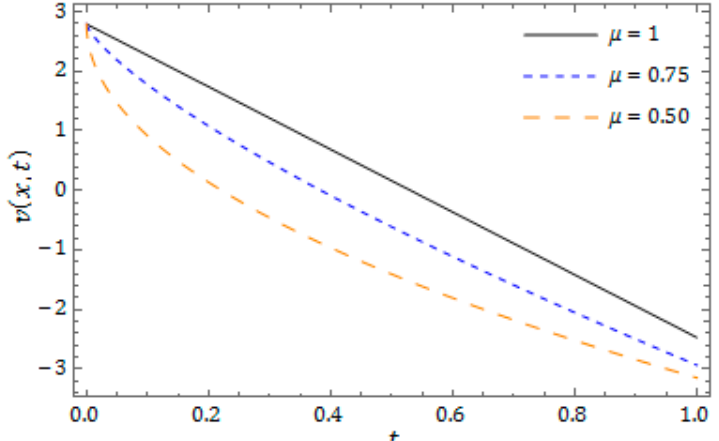
Figure 7. Response of q -HATM solution v ( x , t ) in case ( iii ) with respect to t at (cid:125) = − 1, n = 1, and Figure 7 . Response of 𝑞 -HATM solution 𝑣(𝑥, 𝑡) in case (𝑖𝑖𝑖) with respect to 𝑡 at ℏ = −1, 𝑛 = 1 , x = 1 for diverse µ and 𝑥 = 1 for diverse 𝜇.